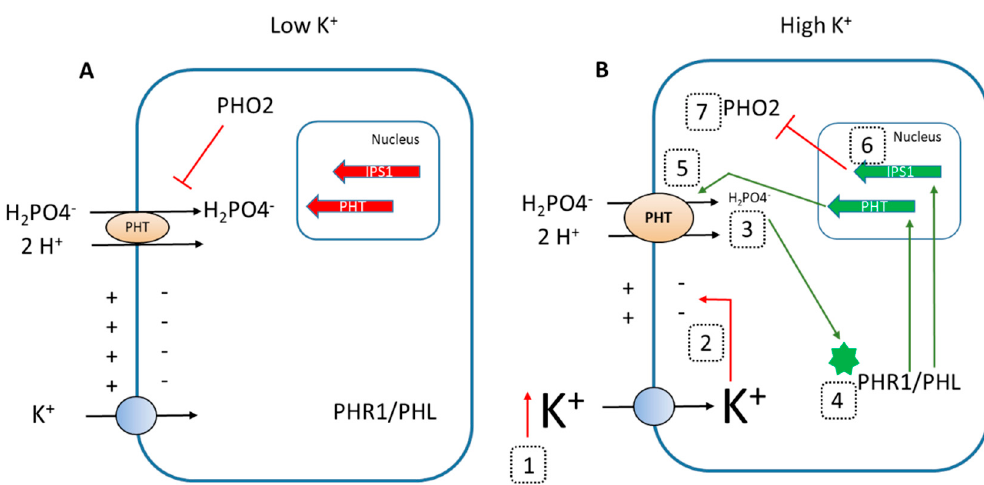
Figure 8. Induction of Phosphate Starvation Respones (PSR) by high external K + . The figure shows a simplified proposed model for the mechanism involved in the induction of the PSR by high external K + . Shown are key elements of the PSR that have been characterized in the present study. ( A ) Under low K + , a non-depolarized membrane potential drives the uptake of H 2 PO4 − through the PHT symporter, the cell does not detect Pi deficient, the PHR1 and PHL1 transcription factors are not activated, the transcription of Phosphate Transporters (PHT) is not induced, and the PHO2 conjugase also reduces their activity. ( B ) In the presence of high external K + (1, red upward arrow), K + uptake depolarizes the plasma membrane potential (2, red arrow), reducing the driving force for H 2 PO4 − and its accumulation in the cell (3). This partial Pi deficiency activates (green arrow) the PHR1 and PHL1 transcription factors (4) that induce the transcription of the PHT genes encoding Pi uptake systems (5, green arrow) and of the non-coding RNA IPS1 (6, green arrow) that indirectly reduces the accumulation of the PHO2 transcript (7), releasing the negative regulation of PHO2 on PHT transporters. The PHT and IPS1 genes are represented by red wide arrows when not induced and by green wide arrows when induced.